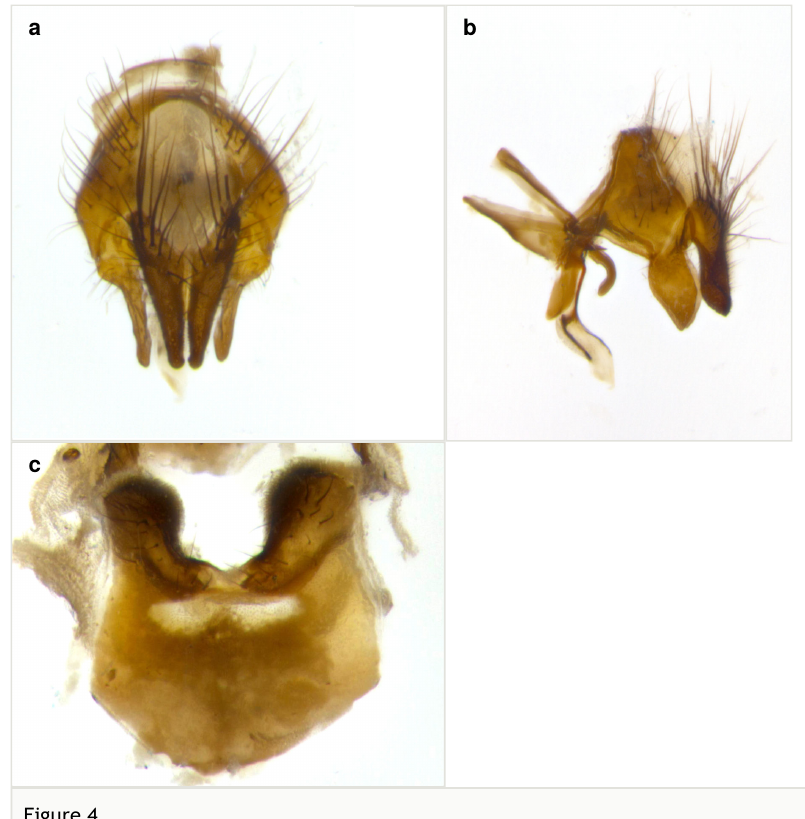
Figure 4. Vibrissina danmartini sp. n. Male terminalia, paratype, voucher code: DHJPAR0017885. a : cerci and surstyli in dorsal view b : terminalia in lateral view c : sternite 5 in ventral